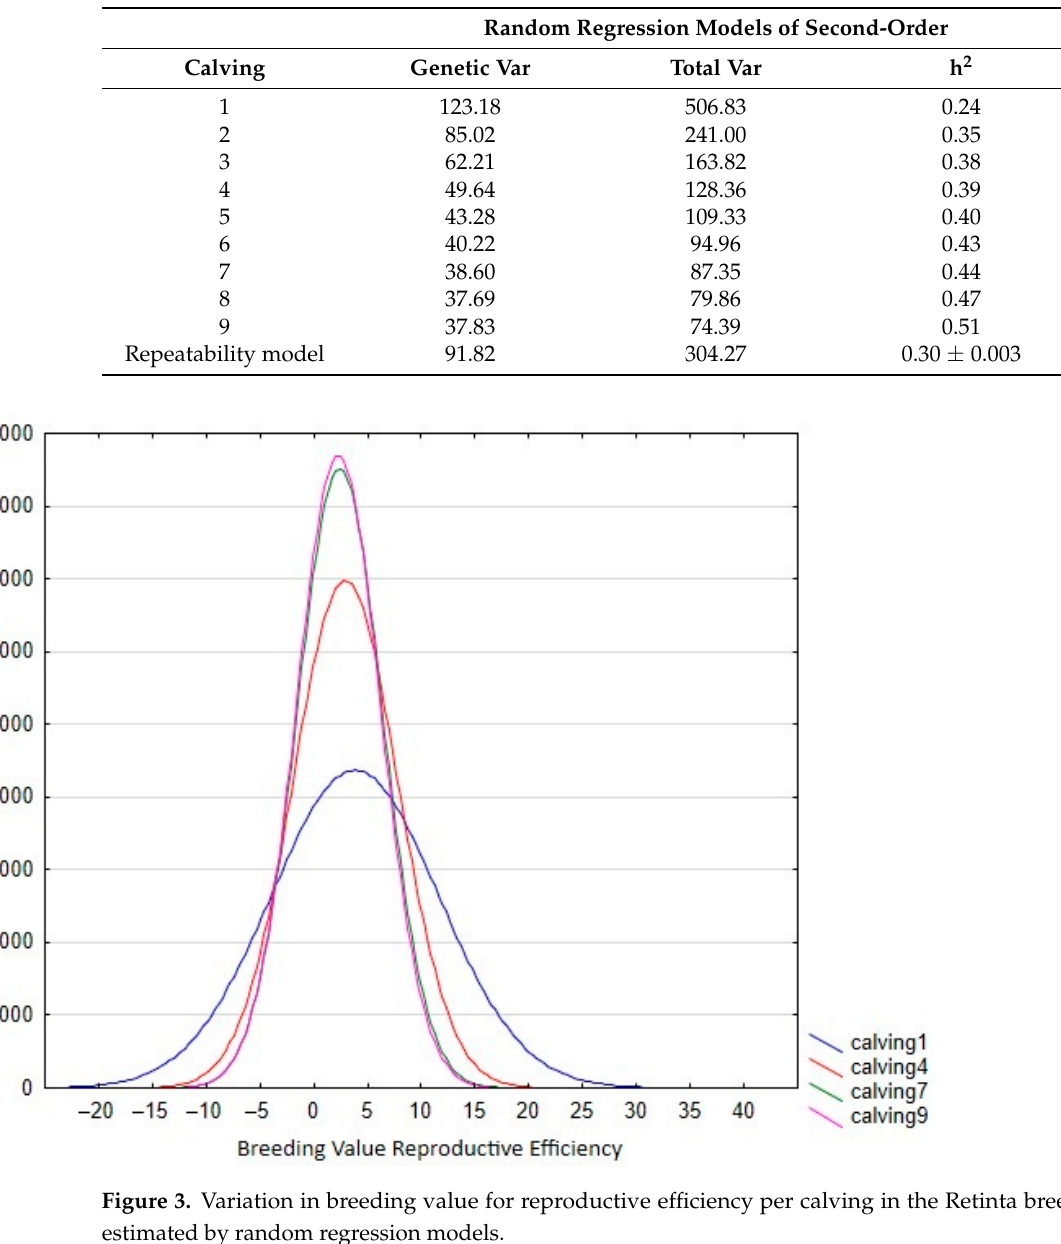
Table 4. Genetic parameters for reproductive efficiency of the Retinta breed throughout the different calvings were estimated by repeatability (REP) and random regression models (RA).